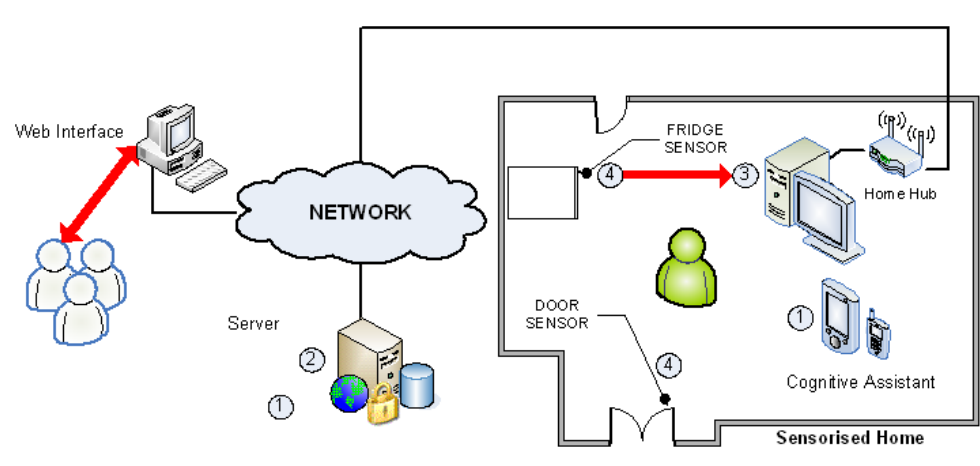
Figure 3. CogKnow‘s system